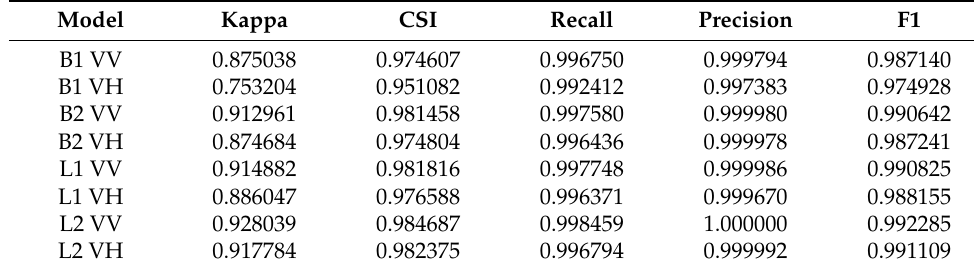
Table 3. Maximum value for the metrics used in the accuracy assessment.